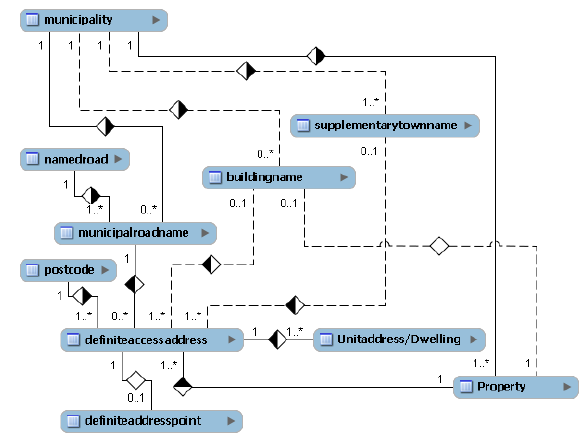
Figure 3: Danish address reference system high level logical model (Lind, 2011). Diagram has been modified to use UML notation and additional entity Property has been